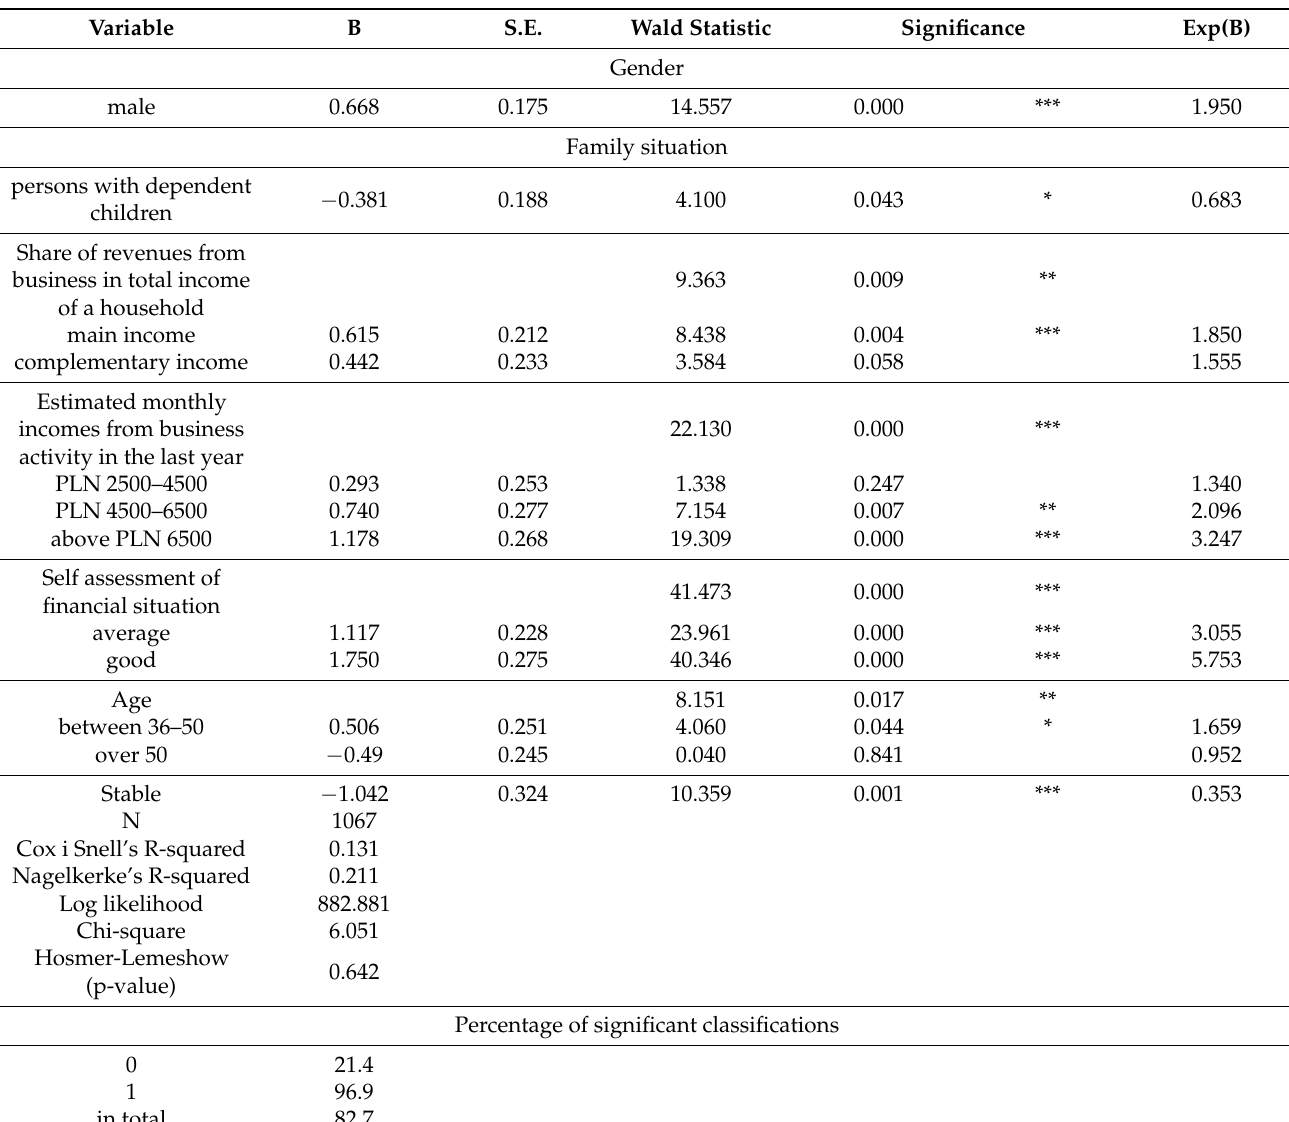
Table 6. Estimation of the logistic regression model—declared retirement savings of independent workers for profit in Poland—statistically significant